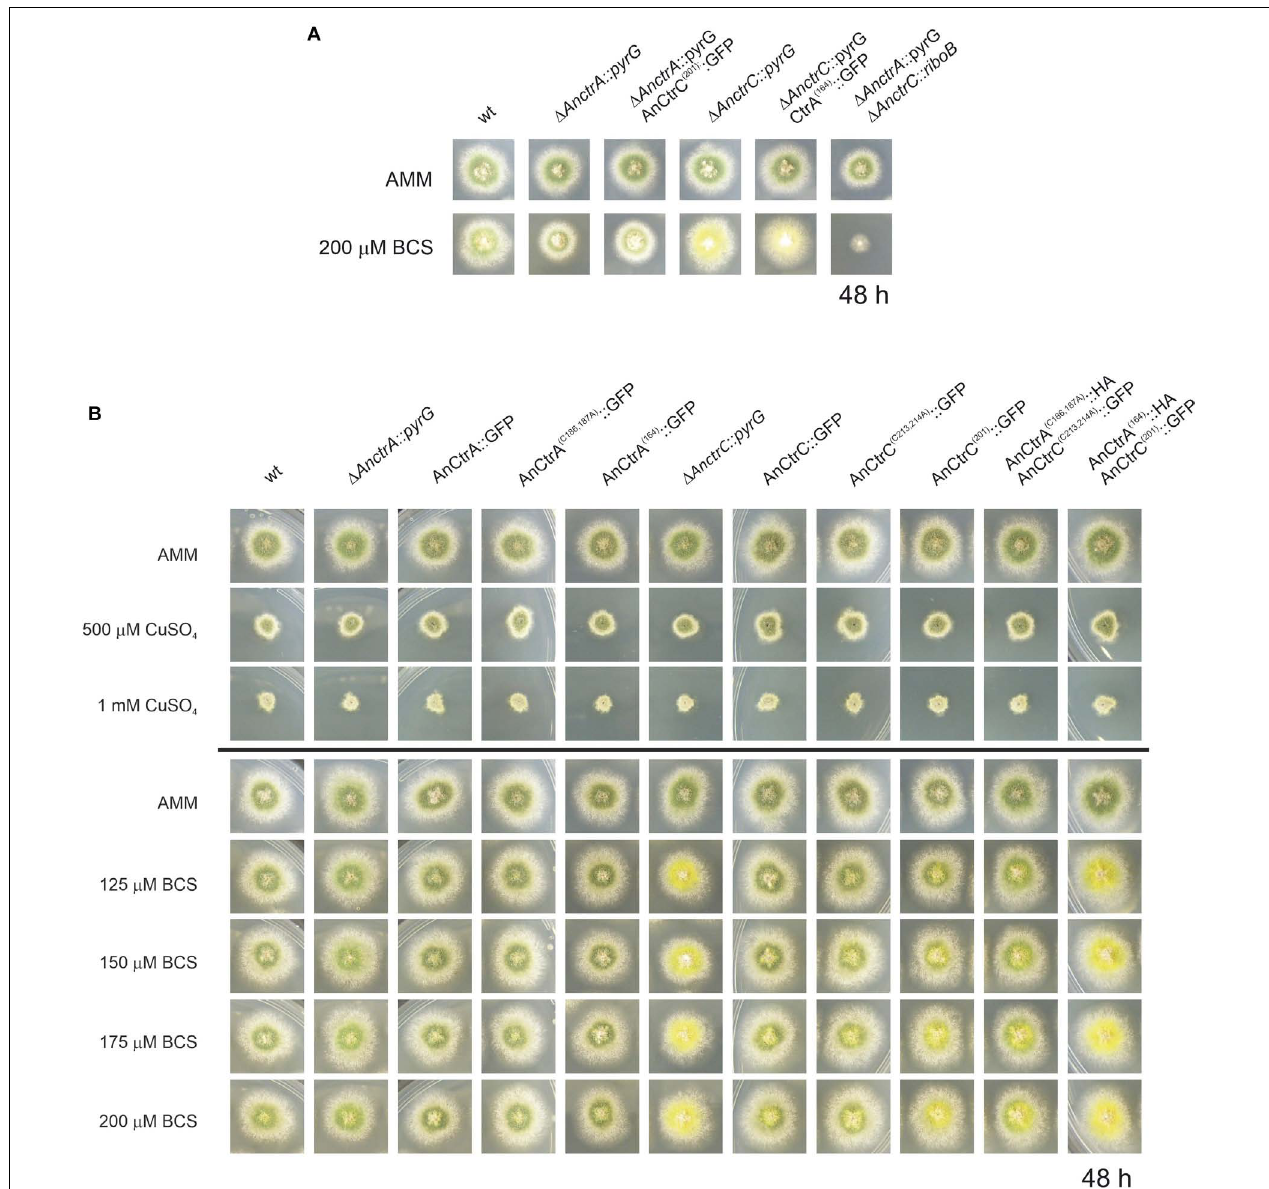
FIGURE 7 | Functional analysis of AnCtrA and AnCtrC C-terminal mutants. (A) Phenotypes of the AnCtrC and AnCtrA C-terminal mutants in AMM and AMM + BCS media to assess protein function. (B) Spores from the mutant strains were point-inoculated and images of colonies were taken after 48 h of incubation at 37 ◦ C in AMM (Aspergillus minimal medium) and AMM with different concentrations of CuSO 4 and